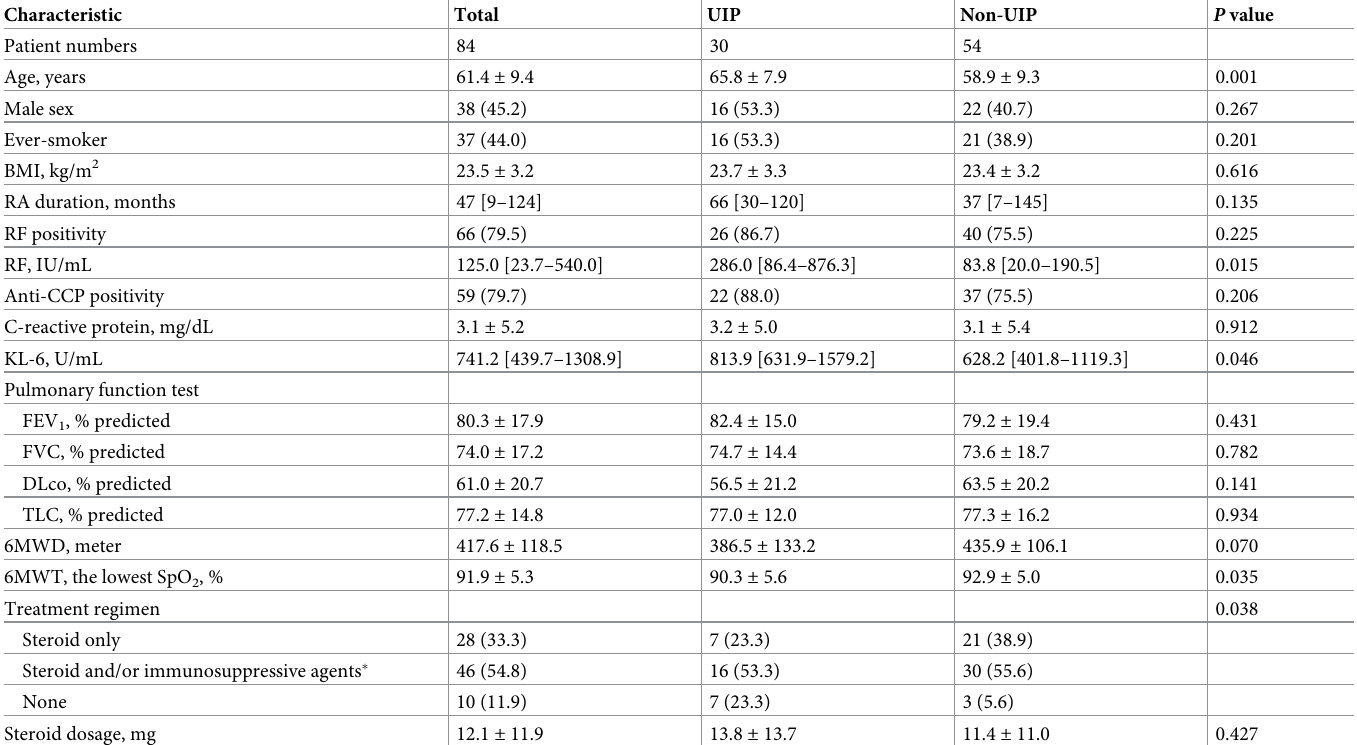
Table 1. Comparison of baseline characteristics between the UIP and the non-UIP groups of RA-ILD patients.